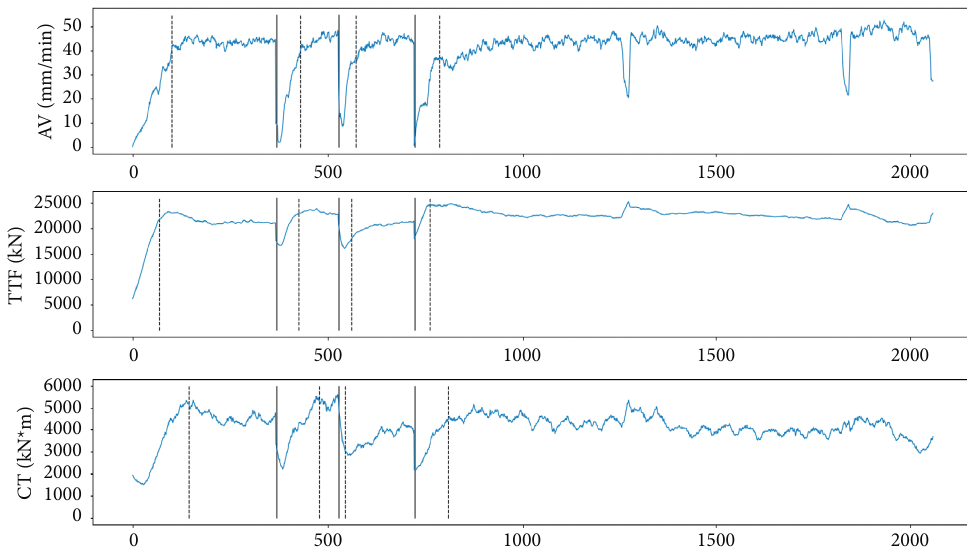
Figure 3: The regression change points of the normal tunneling data segments in Ring